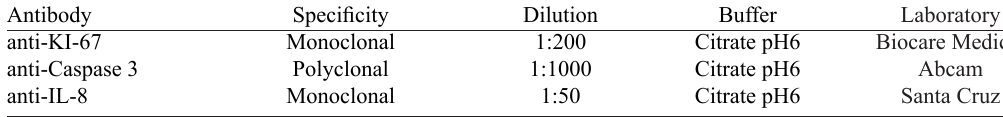
Table 2. Relation of antibodies used